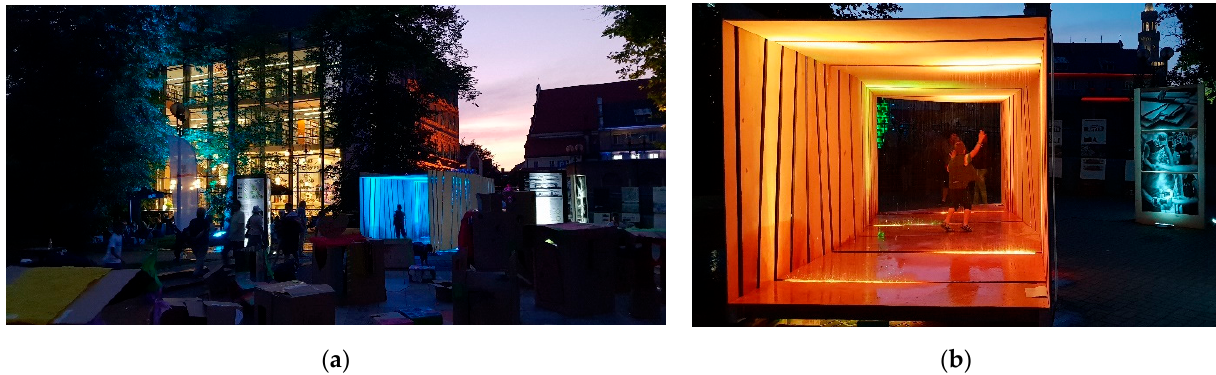
Figure 6. Water Pavilion, 2018: ( a ) the view from the at Plac Wolno ś ci; ( b ) water installation in the pavilion, reproduced with permission from Chamber of Polish Architects branch in Opole.